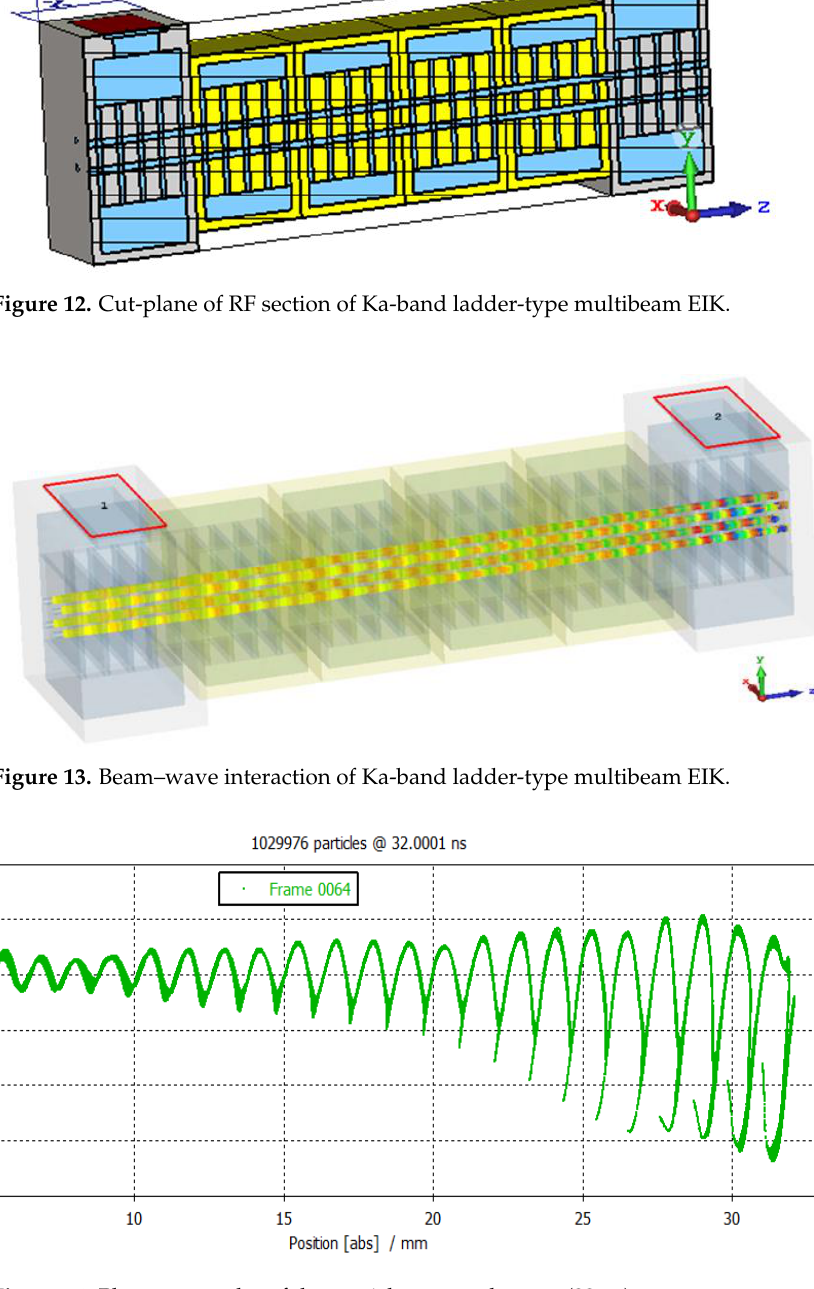
Figure 14. Phase space plot of the particles at steady state (32 ns).